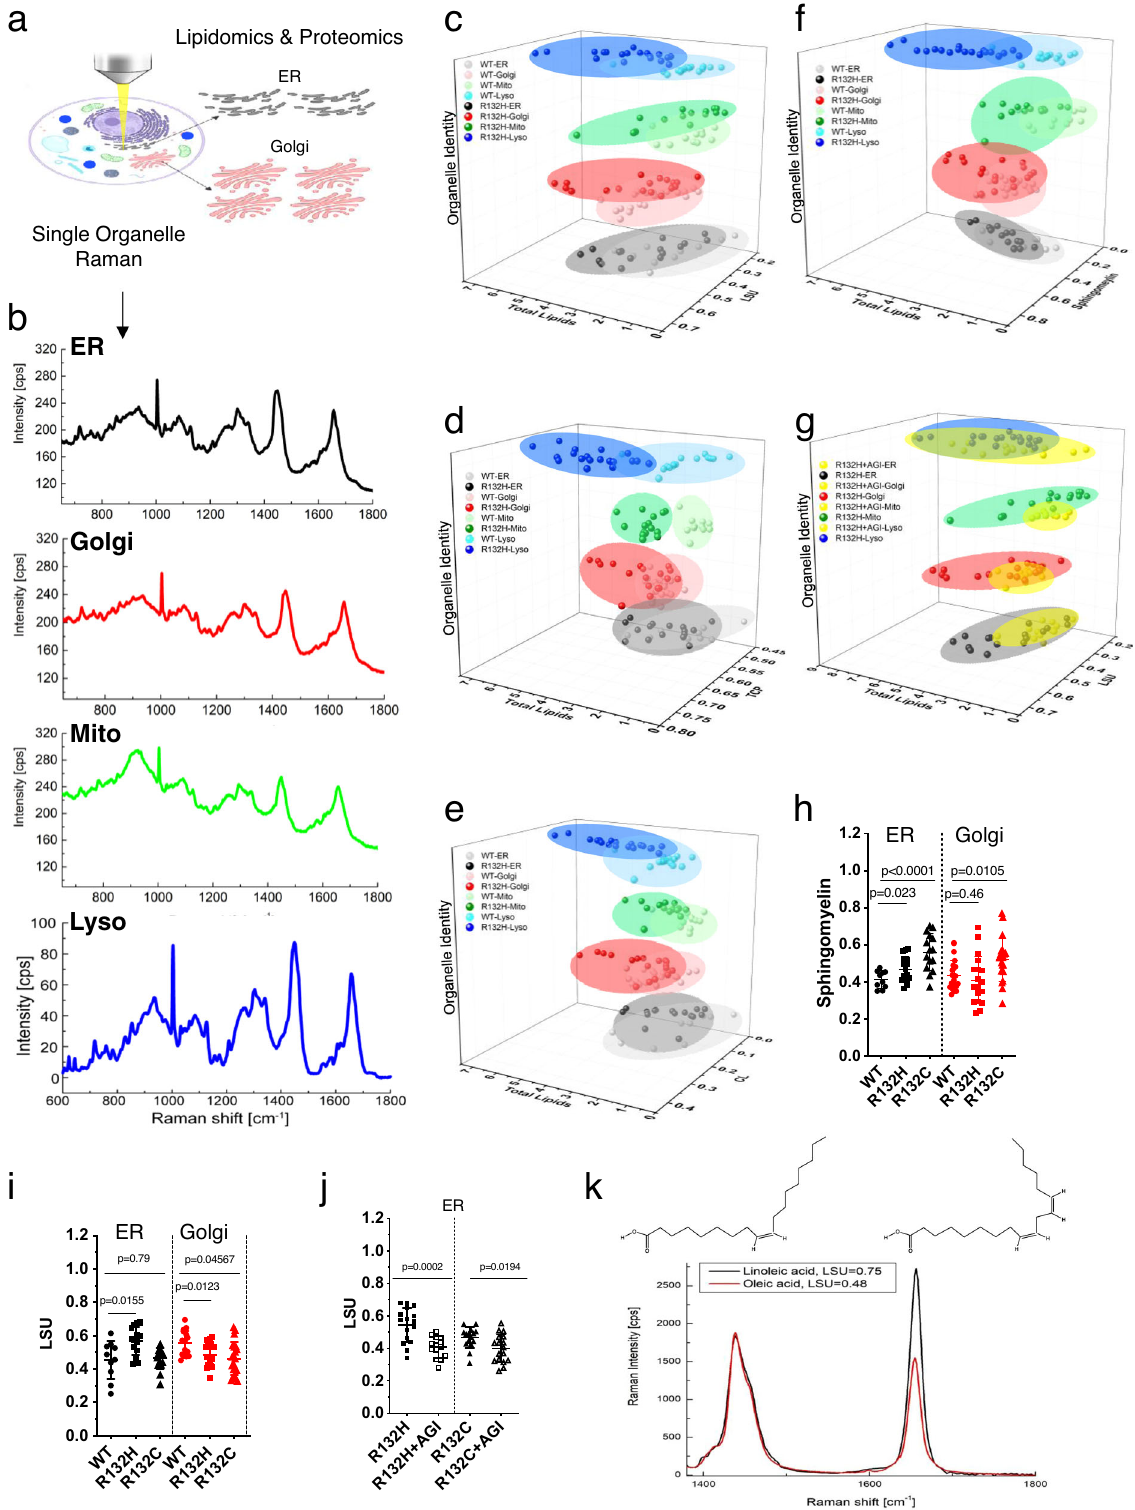
measured the amount of unsaturation, we employed a targeted lipidomic assay via LC/MS of isolated ER and Golgi in order to identify and quantify the different MUFA-containing lipid species altered. U251 R132H/C glioma cells showed a higher relative abundance of SFAs and MUFAs within the ER and a lower relative abundance of polyunsaturated fatty acids (PUFAs) compared to IDH1 WT cells (Fig. 2a, b). The abundance of